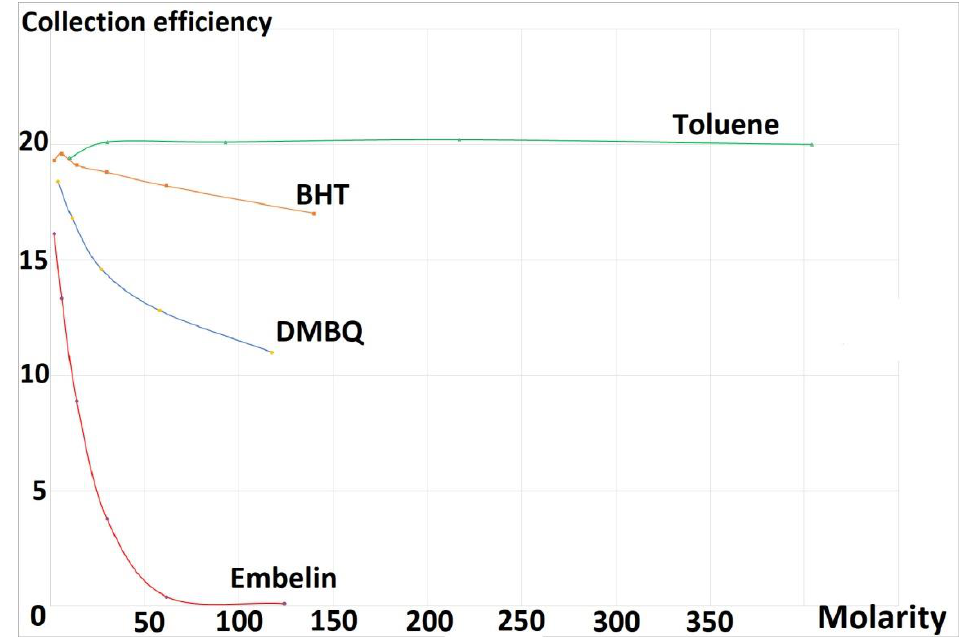
Figure 3. Collection efficiency of the four analyzed species. Molarity expressed as 10 -5 times. Table 1. Slopes of collection efficiency from Figure 3 .